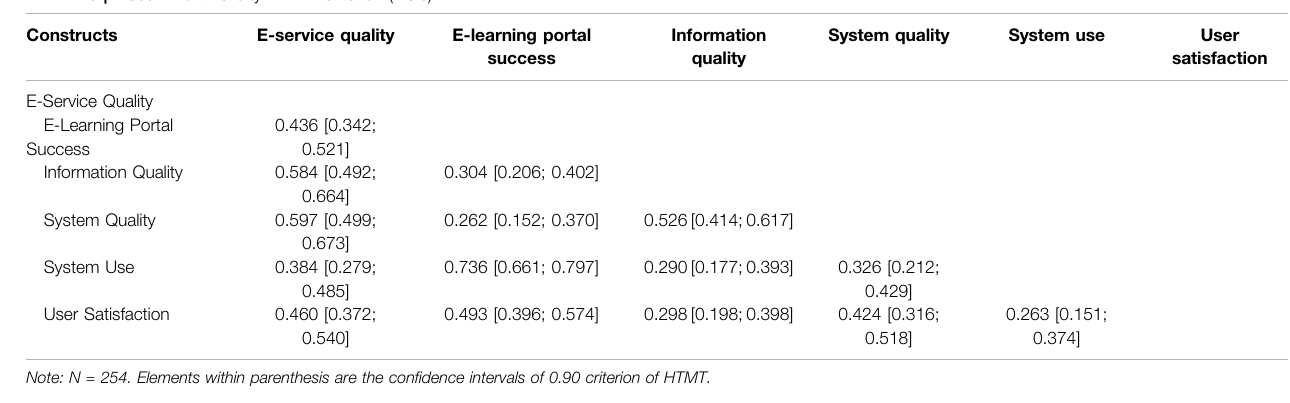
TABLE 6 | Discernment validity: HTMT criterion